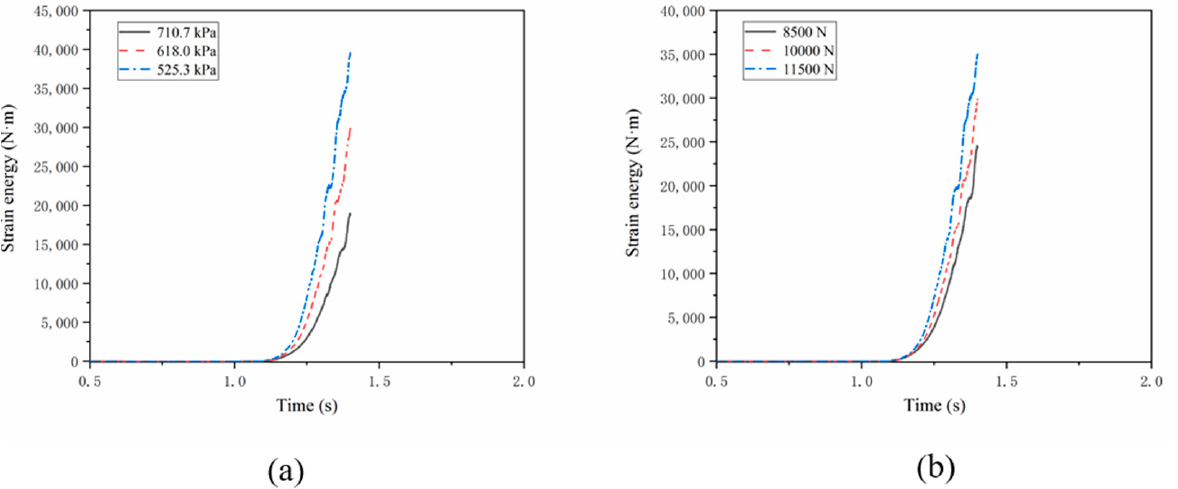
Figure 16. Strain energy consumption: ( a ) with fixed vertical load 10,000 N and different inflation pressure; ( b ) with fixed recommended pressure 618 kPa and different loads.